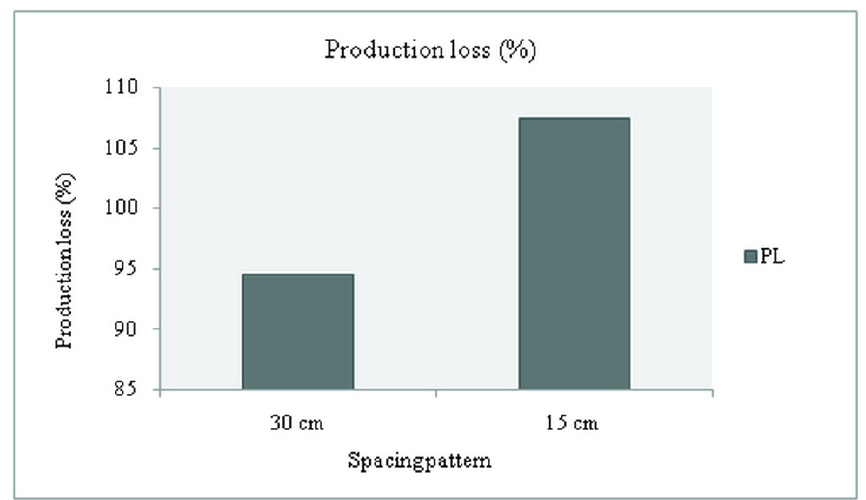
Fig. 1. Production loss (%) in A. hypogaea L. after 30, 60 and 90 days of AM inoculation and 75 days of S. rolfsii treatment in 30 cm and 15 cm plant spacing Values are mean of three replications; PL = Production loss;